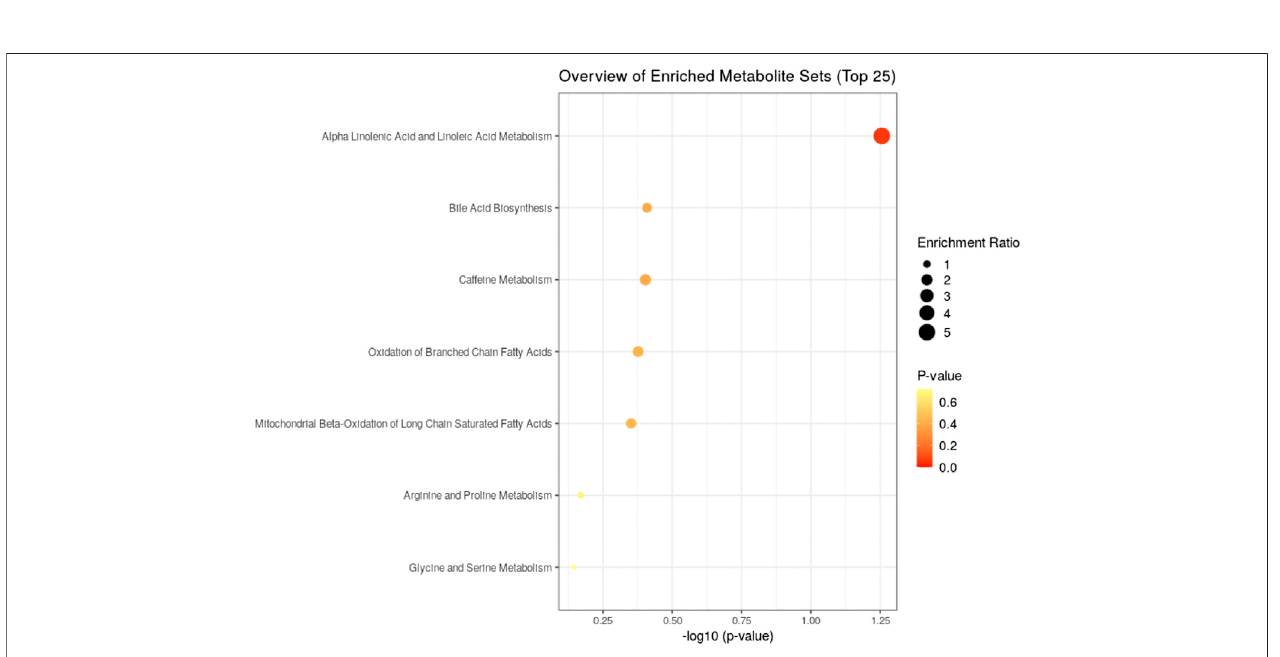
FIGURE 6 | Identi fi ed pathway and the metabolites which have the most impact on the pathway using MetaboAnalyst from enriched metabolites.